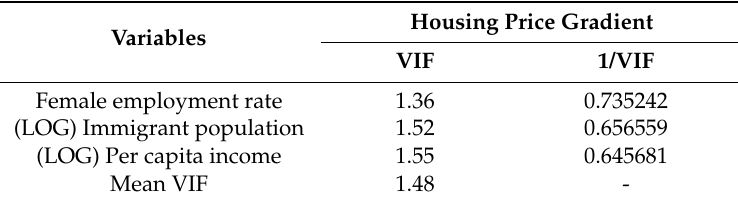
Table 4. Estimation of the variance inflation